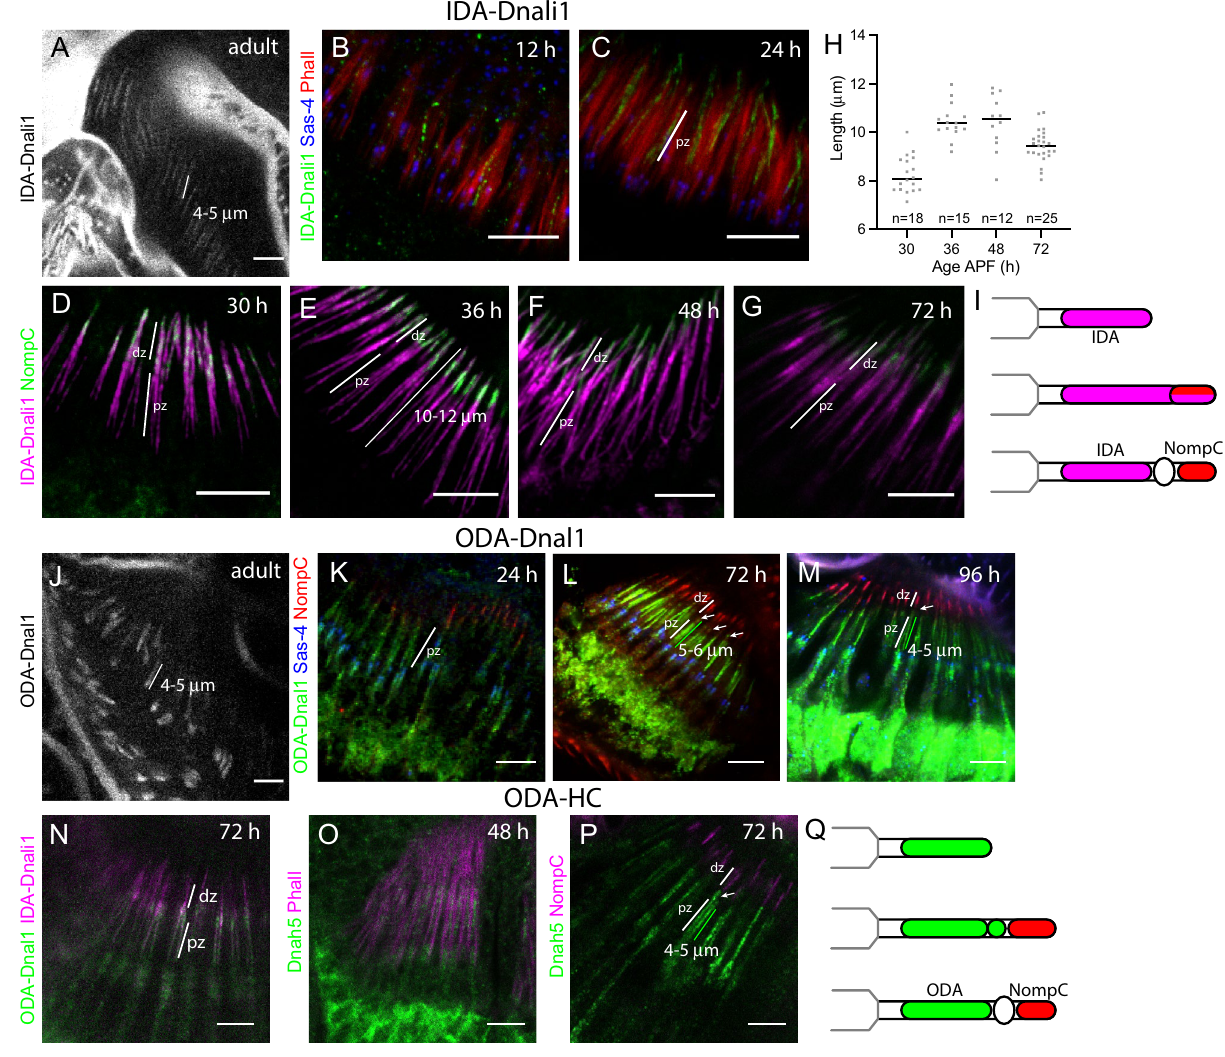
Figure 3. ODA and IDA markers localise differently during ciliogenesis. ( A – I ) Localisation of IDA-Dnali1- mVenus. Pupal antennae at times indicated, and with proximal zones (pz) and distal zones (dz) indicated. ( A ) Adult antenna (mVenus fluorescence). ( B , C ) IDA-Dnali1 enters the cilium early. IDA-Dnali1 (green), Sas-4 (blue), Phalloidin (red). ( D – G ) IDA-Dnali1 localisation extends beyond the proximal zone into the NompC- containing distal zone. IDA-Dnali1 (magenta), NompC (green). ( H ) Graph showing length of Dnali1-mVenus staining. For each time point. ( I ) Schematic summary of IDA-Dnali1 localisation. ( J – Q ) Localisation of ODA- Dnal1-mVenus. Pupal antennae at times indicated. ( J ) Adult antenna (mVenus fluorescence). ( K – M ) Pupal antennae, ODA-Dnal1 (green), Sas-4 (blue), NompC (red). ( K ) ODA-Dnal1 enters the cilium early. ( L ) At 72 h, ODA-Dnal1 localisation is confined to the proximal zone and an accumulation at the ciliary dilation (arrows) ( M ) At 96 h, ODA-Dnal1 localisation is confined to the proximal zone only (arrow marks the location of ciliary dilation). ( N ) 72-h pupal antenna, showing location of ODA-Dnal1-mVenus (green) and IDA-Dnali1-mCherry (magenta). Both are in the proximal zone but only IDA-Dnali1 extends into the distal zone. ( O , P ) Anti-Dnah5 labelling. ( O ) At 48 h, Dnah5 is present in the proximal zone. Dnah5 (green), phalloidin (magenta). ( P ) At 72 h, Dnah5 is in the proximal zone and ciliary dilation (arrow). Dnah5 (green), NompC (magenta). ( Q ) Schematic summary of ODA marker localisation. All scale bars are 5